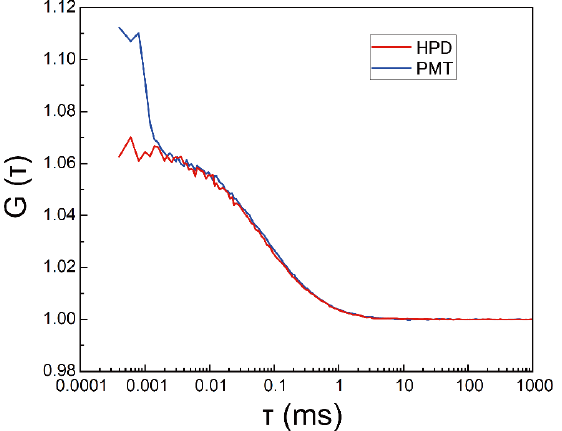
Figure 10. Autocorrelation data obtained by an HPD and a PMT [32]. The data were acquired using 100 nM Alexa Fluor 532 dye solution.